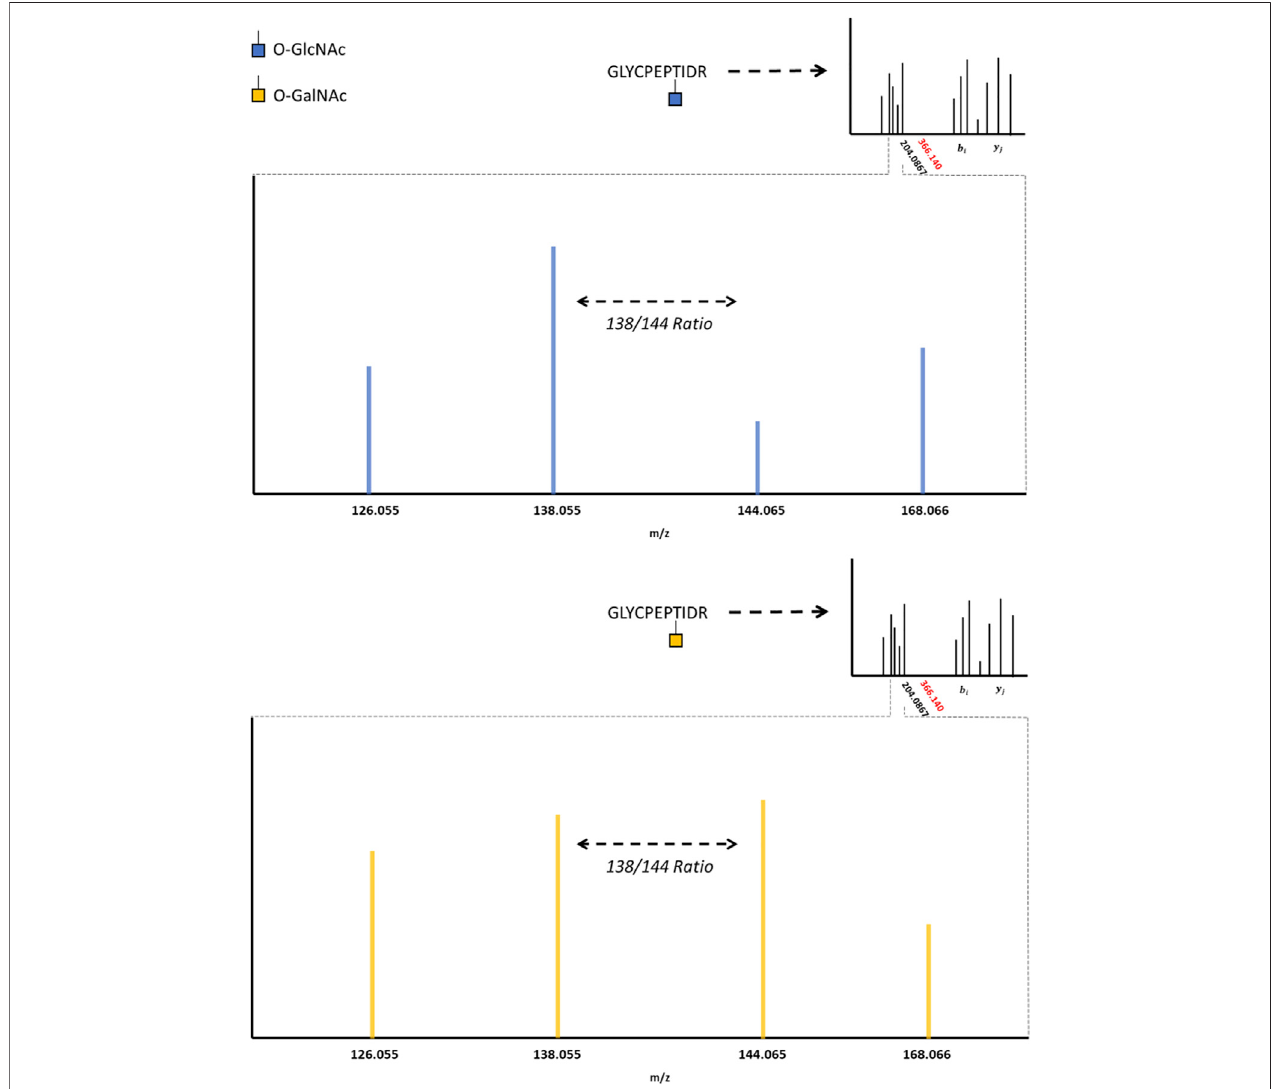
FIGURE 2 | The O-GlcNAc Fingerprint HexNAc fragmentation patterns appear to be distinctive between O-GIcNAc (blue) and O-GalNAc (orange) stereoisomers. Upon collisional induced dissociation, the glycosidic bond between serine/threonine and the HexNAc modi fi cation is liberated, producing a characteristic 204.0867 peak. The liberated HexNAc ion can further fragment, producing the 168.066, 144.065, 138.055, and 126.055 m/z peaks. The relative ratio between these fragment peaks (such as the 138/144 ratio) are reported to be different between O-GIcNAc and O-GalNAc. The lack of a 366.140 peak, as indicated by the red marking on thespectruminlet,indicatestheabsenceofaHexHexNAcpeak(theabsenceofabranchedglycan).Importantly,thesefragmentationpatternsmayvarybetweendistinct HexNAc precursors and instrument settings; however,thetrends distinguishing O-GIcNAc fromO-GalNAc appear tobeconsistent (Halim etal.,2014;Burt et al.,2021; Pirro et al.,